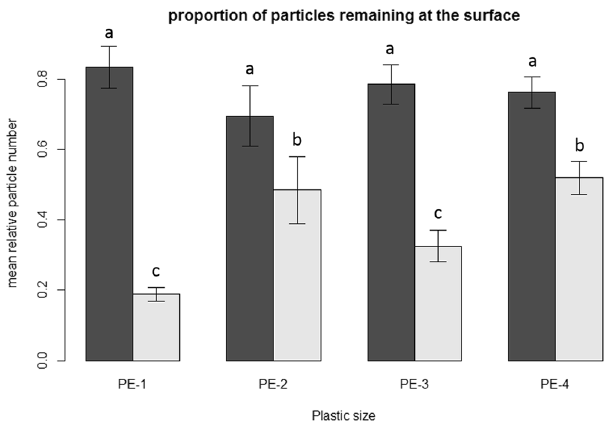
Figure 1. Mean relative microplastic particle numbers recovered from the soil surface after the experiment (expressed as a percentage of the number of particles added to the soil surface at the beginning), error bars indicate standard error. Dark grey bars show values in absence of earthworms, while light grey bars give data with earthworms. Results are shown for four different particle size ranges: 710–850 μ m (PE-1), 1180–1400 μ m (PE-2), 1700–2000 μ m (PE-3) and 2360–2800 μ m (PE-4). Different letters above bars indicate significant differences (P < 0.05; Tukey-Kramer